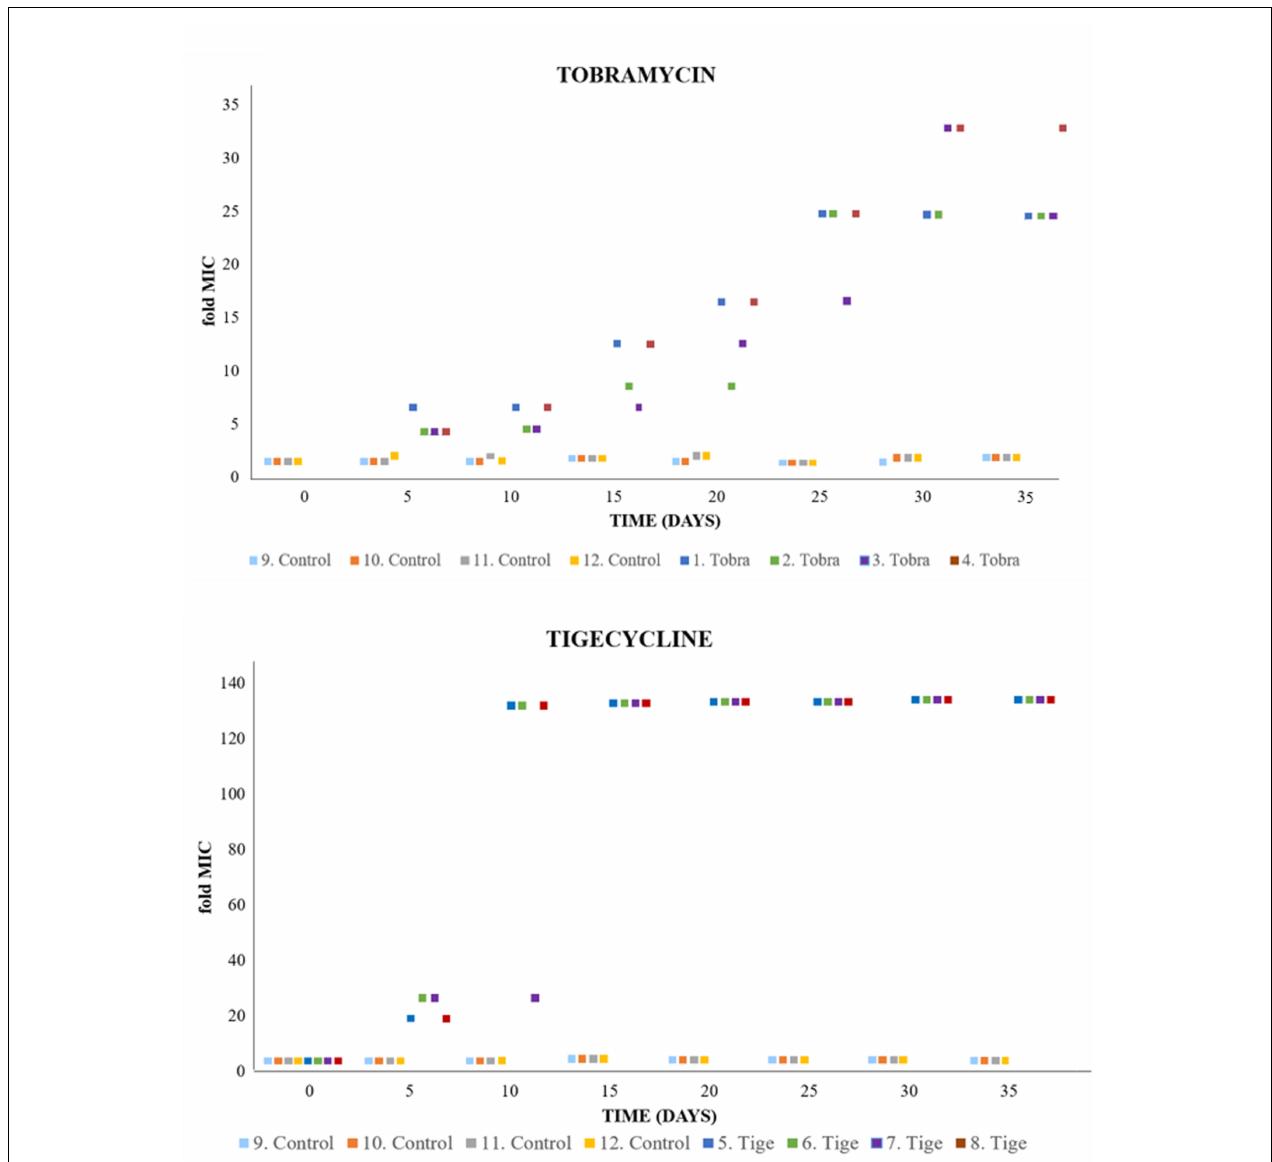
FIGURE 1 | Evolution of P. aeruginosa under antibiotic selective pressure. Graphs show the rise of the MICs over the evolution period, from the value corresponding to the wild-type strain (tobramycin [Tobra], 1 µ g/ml; tigecycline [Tige], 2 µ g/ml) to high levels of tobramycin/tigecycline resistance (doubling the antibiotic concentration every 5 days). The detection limit of the tigecycline E -test was 256 µ g/ml, limiting the assessment of resistance levels from day 15 to the end of the experiment. MIC values for each replicate are provided in Supplementary Table S3